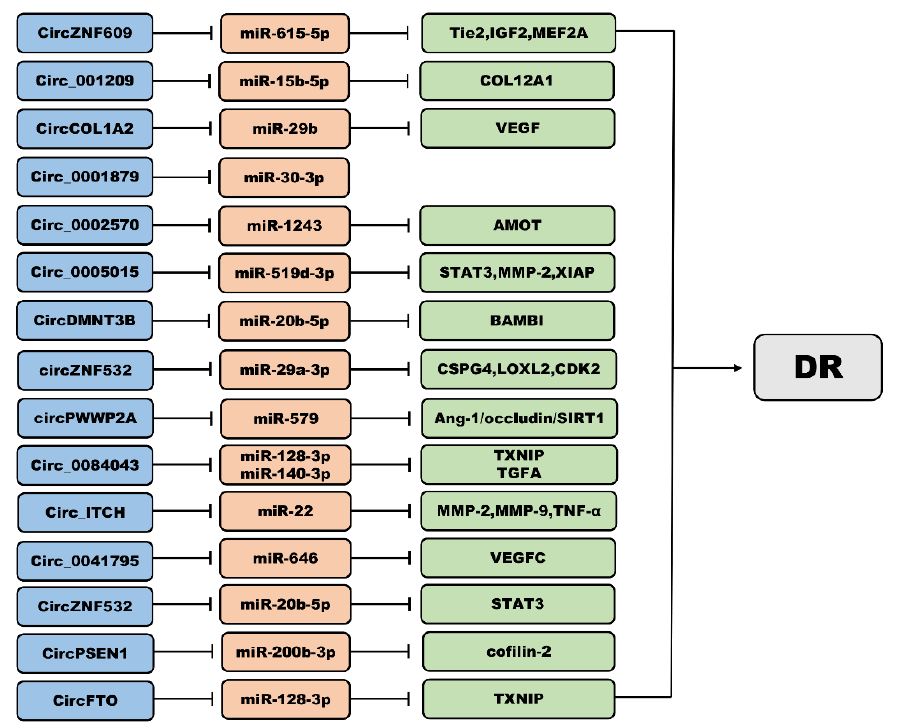
Figure 3. Main circRNAs involved in DR pathophysiology.